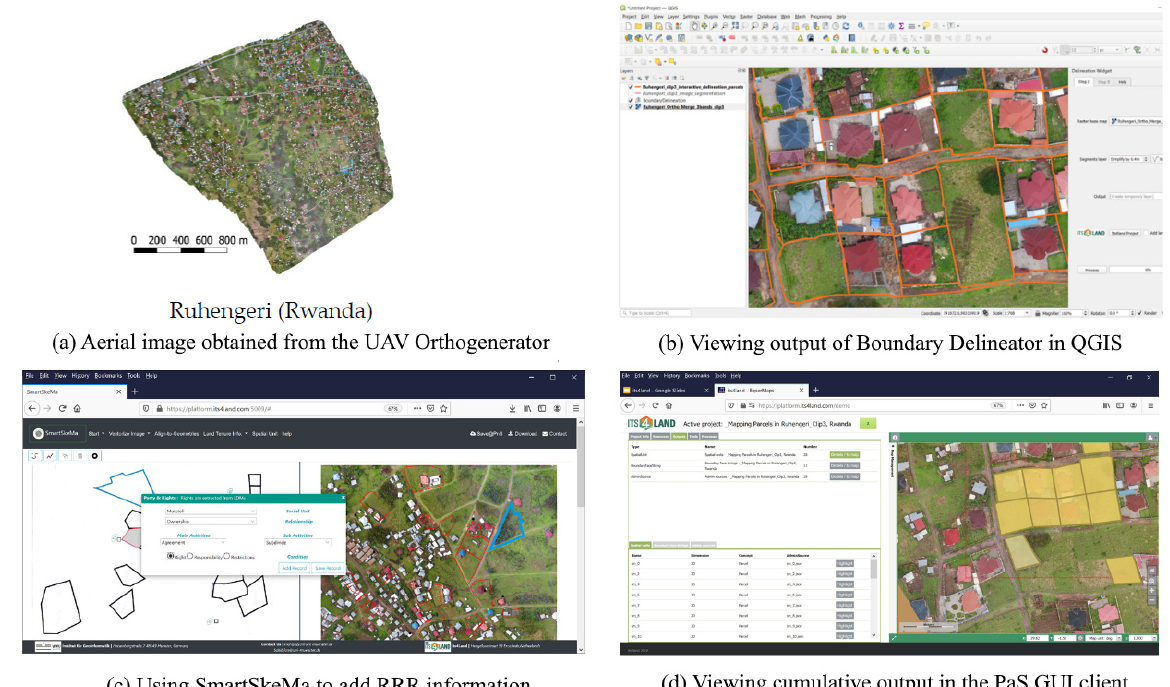
Figure 6. Example workflow using PaS and tool in Ruhengeri, Rwanda.